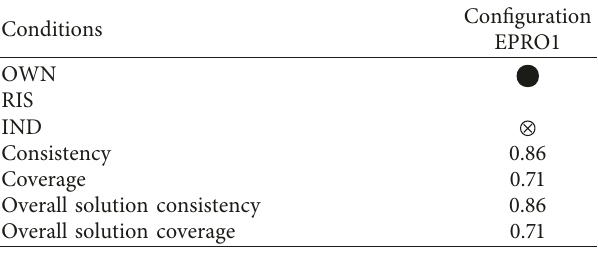
Table 7: The configuration of process